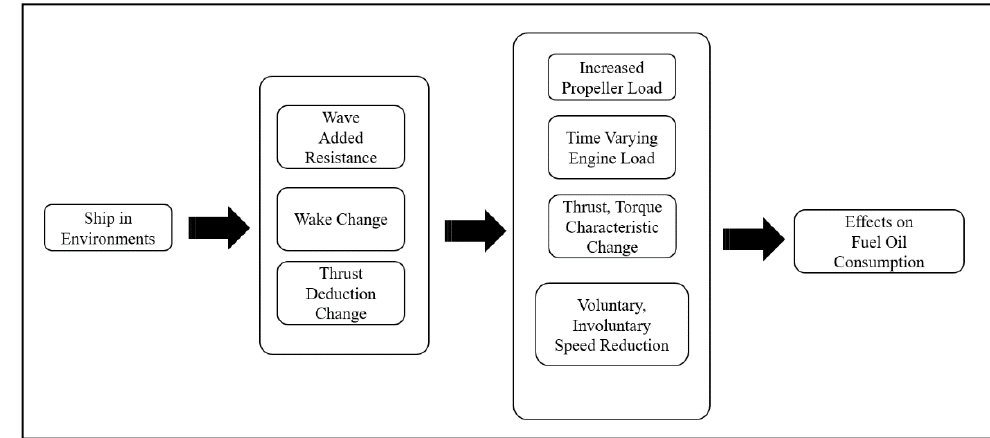
Figure 4. Environmental effects on ship fuel oil consumption